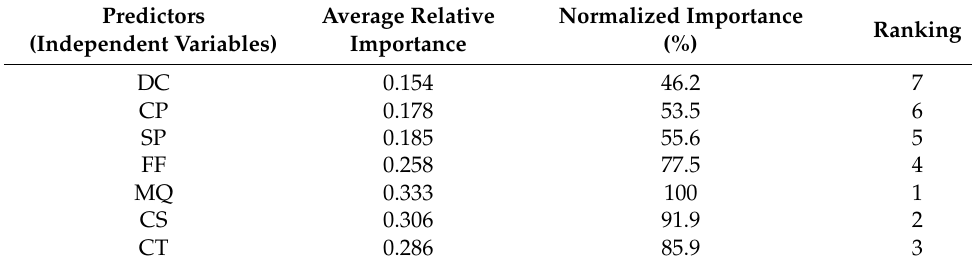
Table 10. Normalized variable relative